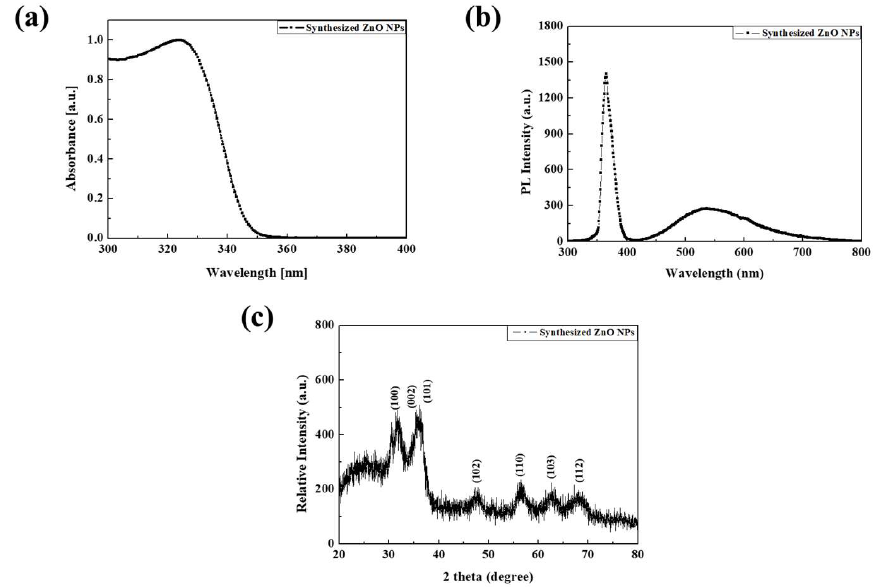
Figure 3. ( a ) Absorbance property, ( b ) PL characteristic and ( c ) XRD analysis of the synthesized ZnO NPs.